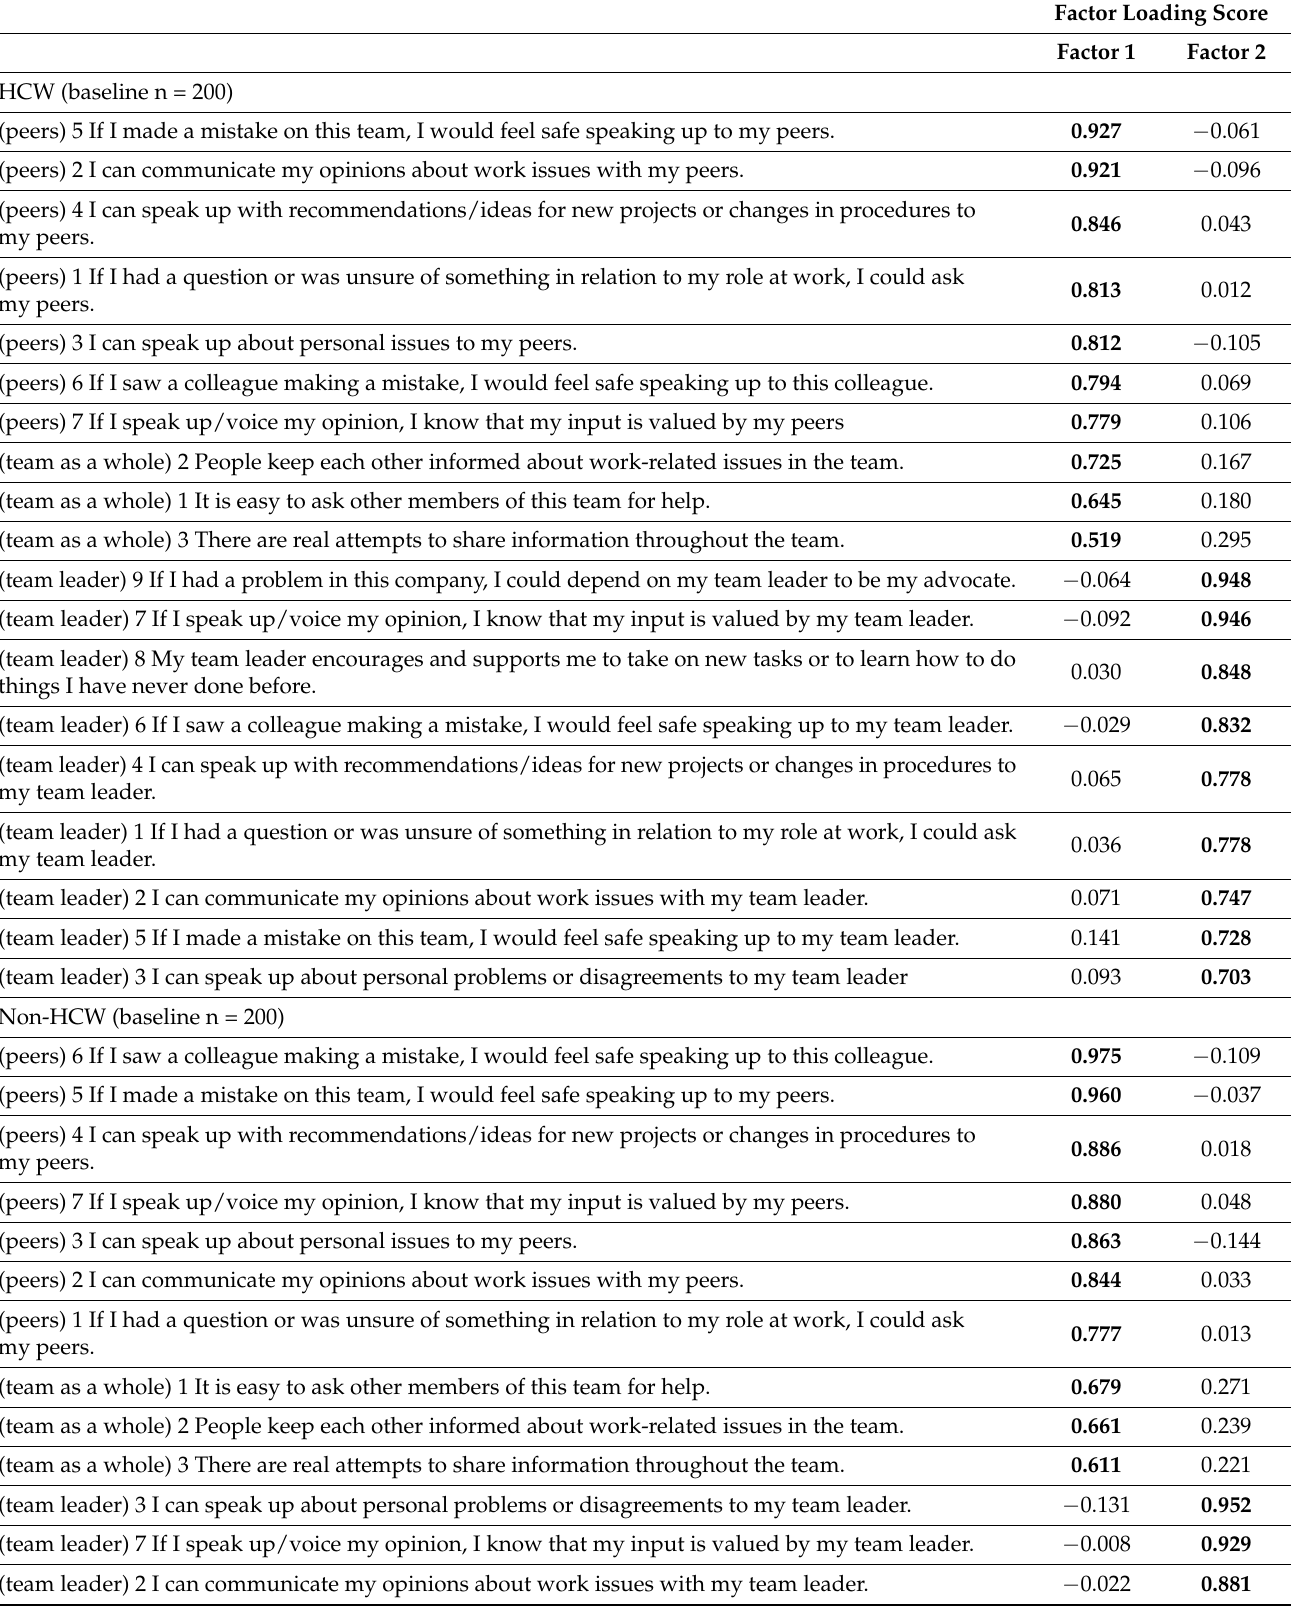
Table 4. Exploratory factor analysis without assuming the number of factors by using maximum likelihood method with Promax